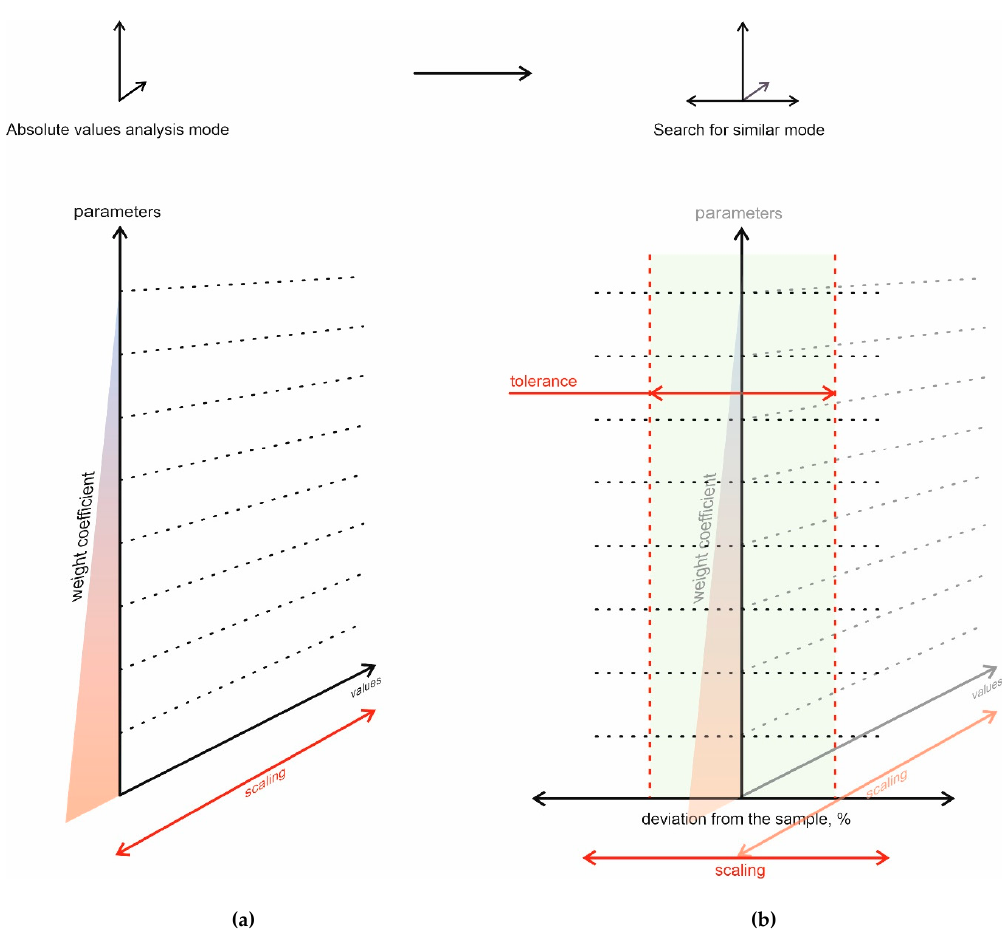
Figure 2. Conceptual scheme of a visual data model: ( a ) 2D mode; ( b ) 3D mode